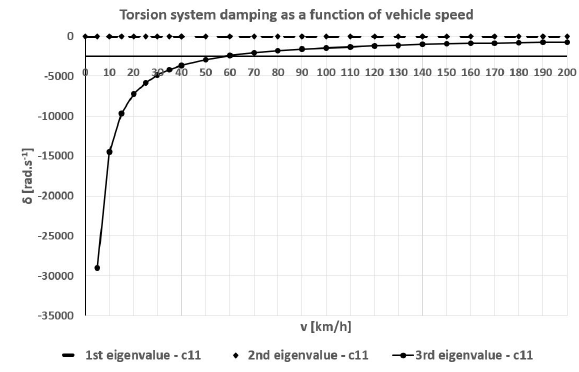
Figure 17. Damping as a function of velocity – c